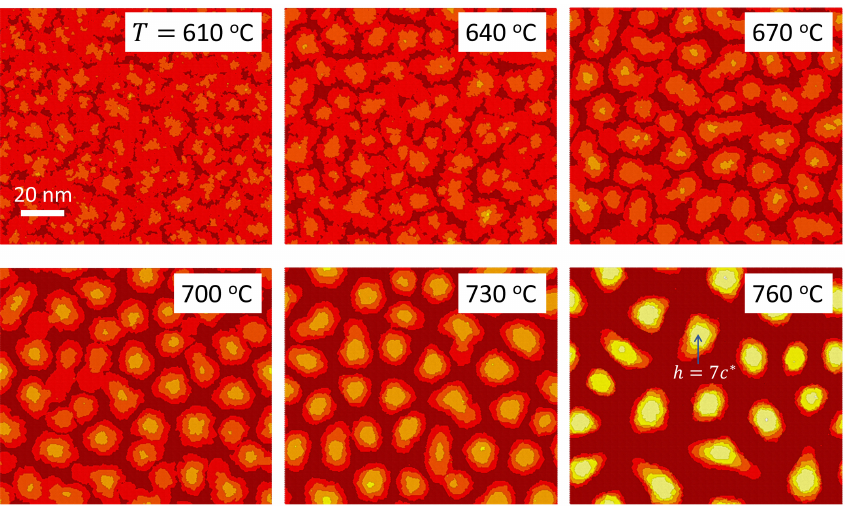
Figure 7. Surface morphology of a GaN epitaxial layer grown on an AlN substrate as obtained by simulations performed at different temperatures (specified in each panel of the figure). The color scale indicating the discrete height is the same for all panels. A reference height is provided in the panel for T = 760 ◦